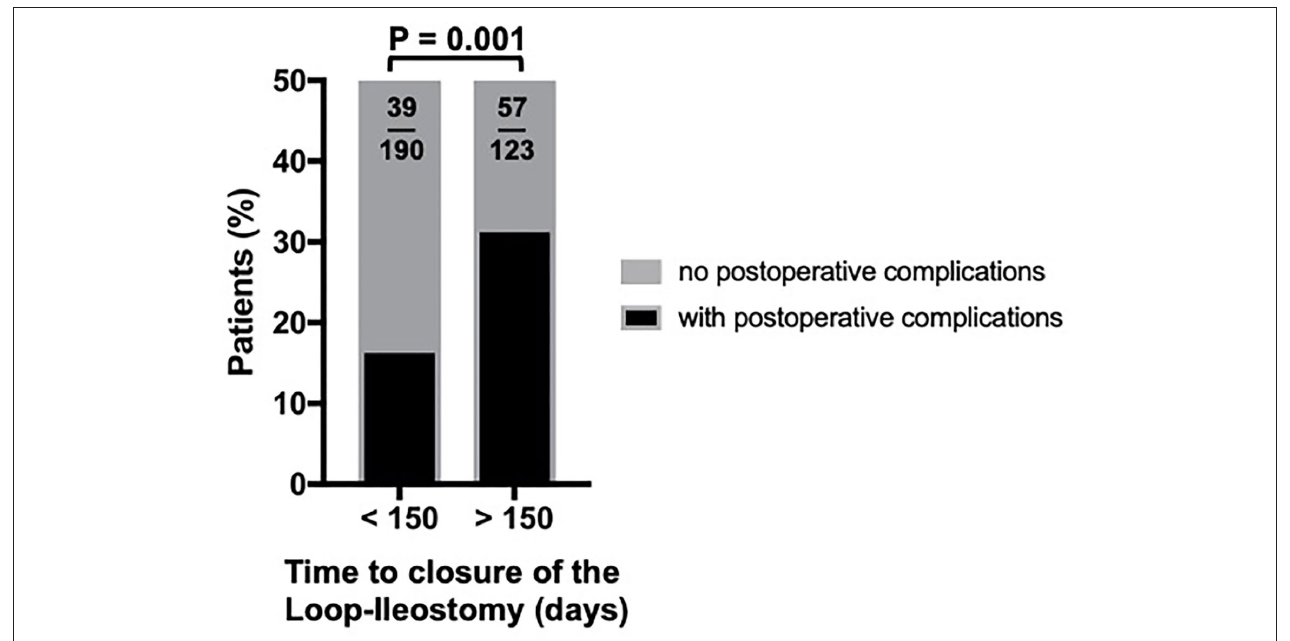
FIGURE 1 | Complications depending on the time to closure of the protective loop-ileostomy.